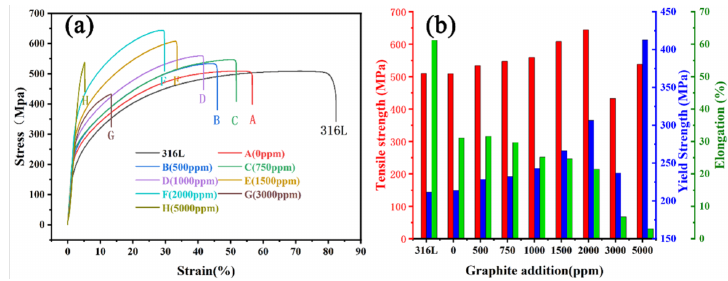
Figure 7. Mechanical properties of sintered 316 L stainless steel and heat-treated novel nitrogen- free austenitic stainless steel samples with the addition of different concentrations of graphite.